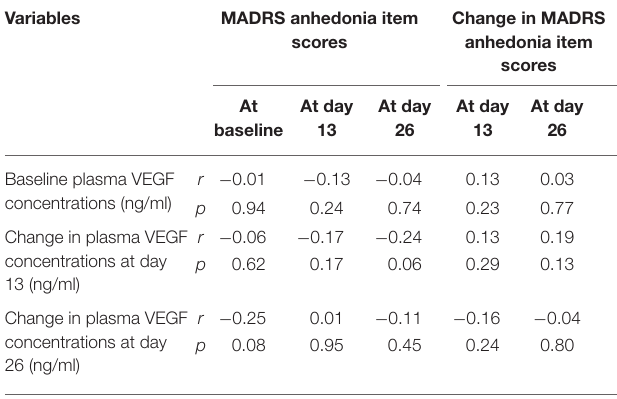
TABLE 3 | Relationship of baseline plasma VEGF concentrations and anhedonia symptoms in subjects suffering from TRD.